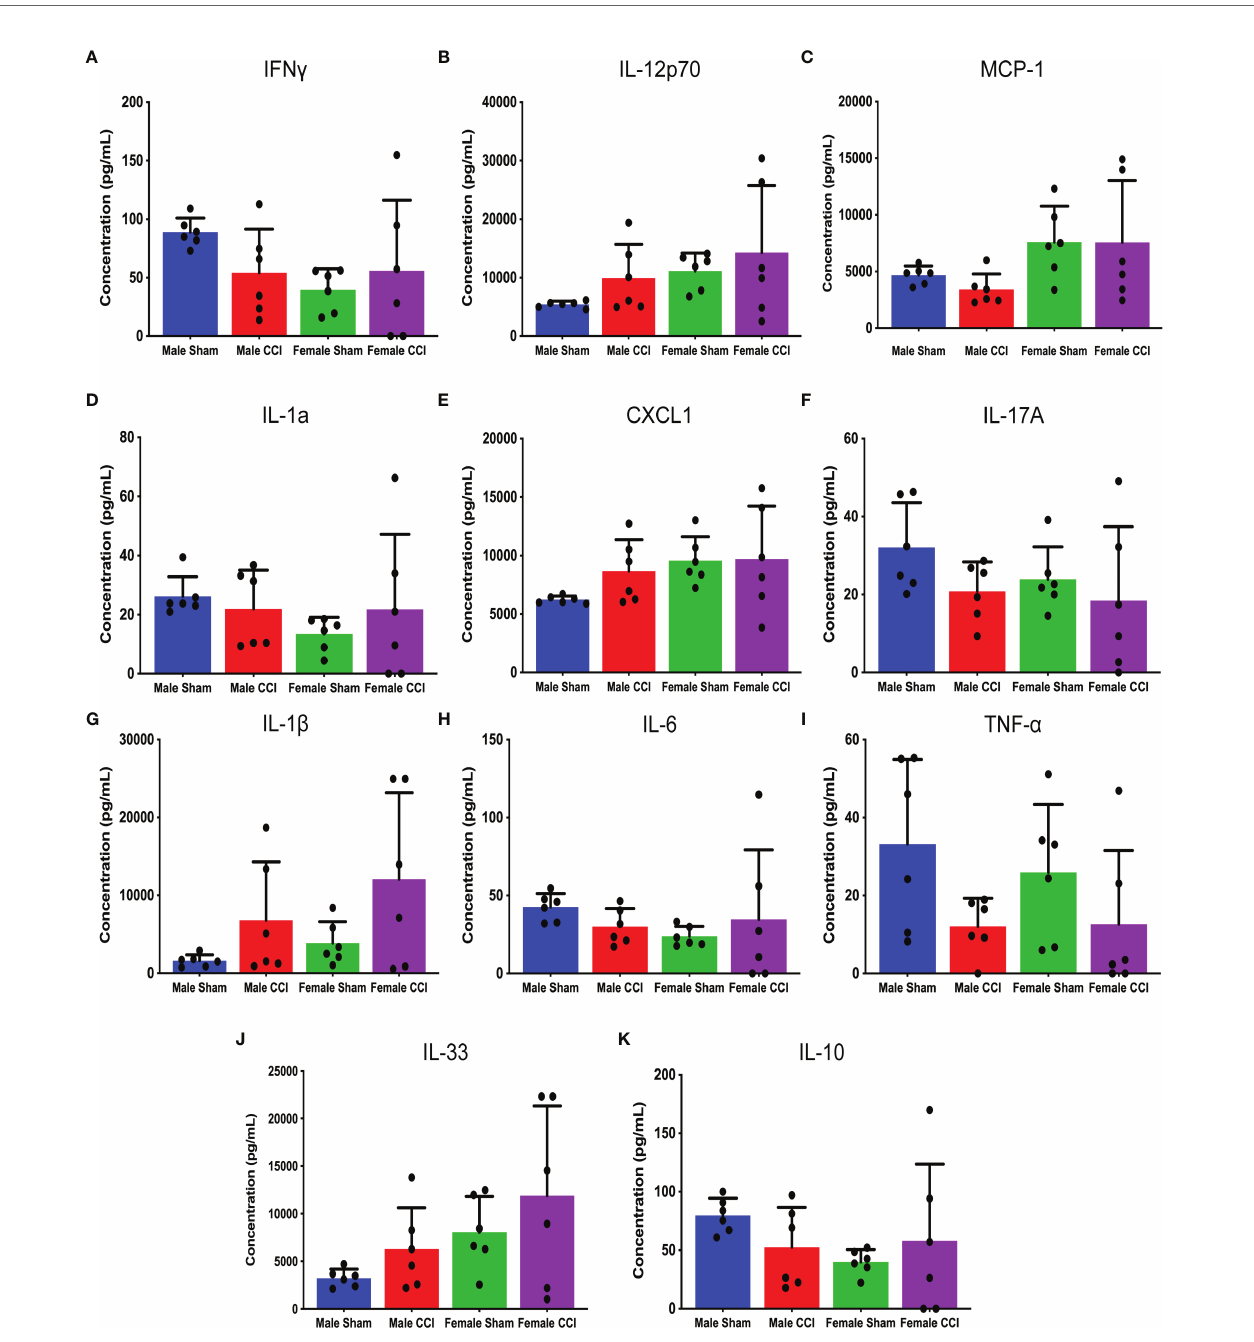
FIGURE 4 | Multiple in fl ammatory cytokine analysis of cerebral tissue culture. The above charts depict the mean concentrations of individual cytokines in cerebral tissue cultures detected by the cytokine assay. The following cytokines were analyzed in this assay: IFN- g (A) , IL-12p70 (B) , MCP-1 (C) , IL-1A (D) , CXCL-1 (E) , IL-17A (F) , IL-1 b (G) , IL-6 (H) , TNF- ⍺ (I) , IL-33 (J) , IL-10 (K) . While there were multiple differences detected between the male CCI and female CCI groups regarding speci fi c cytokine levels, none of these differences reached statistical signi fi